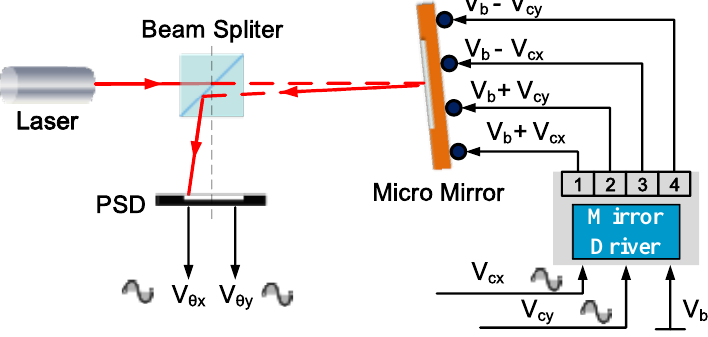
Figure 3. Setup to measure open-loop frequency response of micromirror tilting. PSD: position sensitive detector; V b : biased voltage; V cx and V cy : the control voltages in x and y directions; V θx and V θy : PSD output signals proportional to the mirror tilt angles in both directions of x and y .